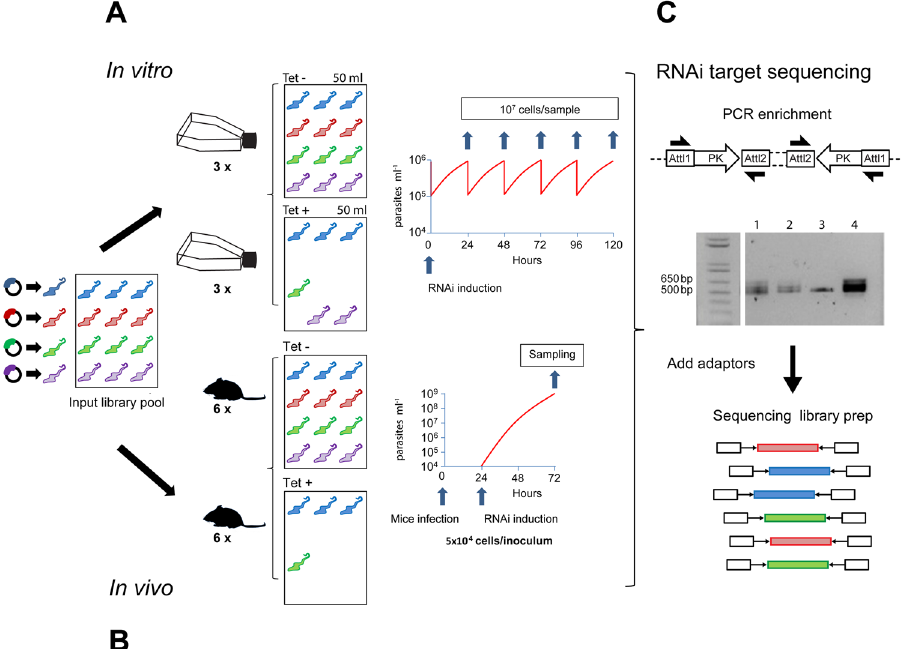
Figure 1. In vitro and in vivo phenotyping of a T. brucei kinome RNAi library. Schematic representation of the experimental workflow. ( A ) A pre-inoculation pooled kinome RNAi library was diluted to contain 1 × 10 5 cell ml − 1 in 100 ml and grown in culture for 24 h in triplicate. Each culture was then split into two flasks, one in which RNAi was induced with tetracycline (Tet + ) and the other remained uninduced (Tet − ). 1 × 10 7 cells were sampled every 24 h over 5 days for DNA purification and cultures diluted daily to contain 1 × 10 5 cells ml − 1 . ( B ) 5 × 10 4 T. brucei bloodstream form parasites of the pooled kinome RNAi library were injected intraperitoneally into 12 CD1 mice and 24 h post inoculation, RNAi was induced with doxycycline in 6 animals (Tet + 1–6) and 6 were left uninduced (Tet − 1–6). 48 h post RNAi induction, parasites were purified from blood and genomic DNA prepared. ( C ) PCR enrichment of the RNAi target was carried out. The cropped gel example shows RNAi target distribution in 4 different samples: Tet − (1), Tet + (2), a single cell line control (3), and the preinoculation pool (4). The experiment was performed twice and PCR-enriched samples from each biological replicate were sequenced. A full-length gel is presented in Figure